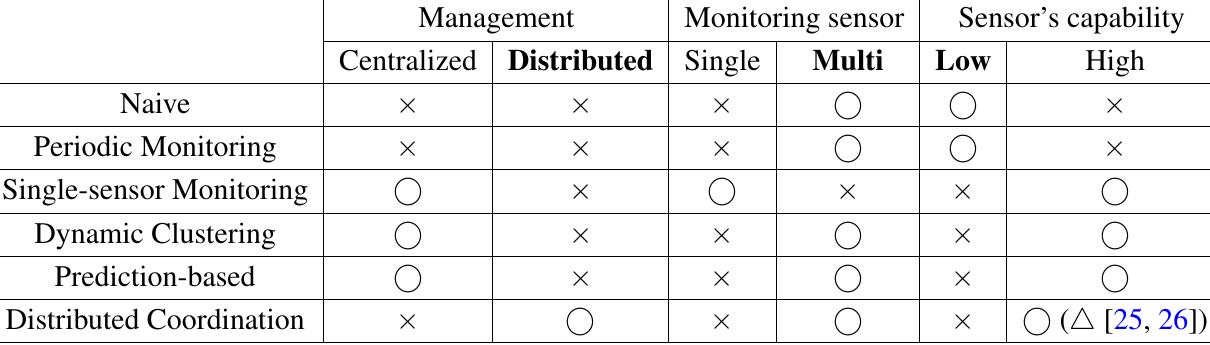
Table 1. Architecture and sensor’s capability employed in existing target tracking schemes. Management Monitoring sensor Sensor’s capability Centralized